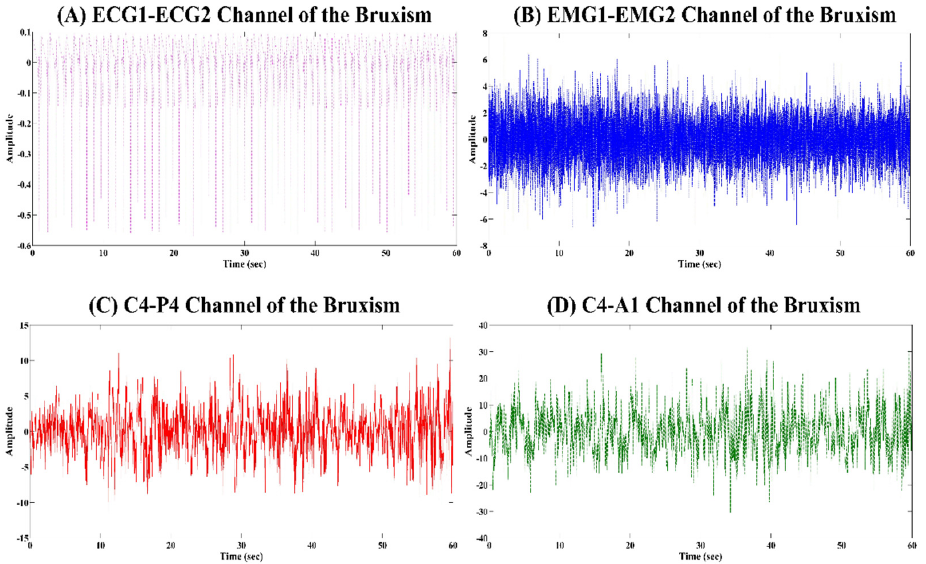
Figure 3. Signal representation of the sixty-second sleep physiological channels such as ( A ) ECG1-ECG2, ( B ) EMG1-EMG2, ( C ) C4-P4, and ( D ) C4-A1 of the bruxism subjects. A 10 / 20 standard sleep recording system recorded them.